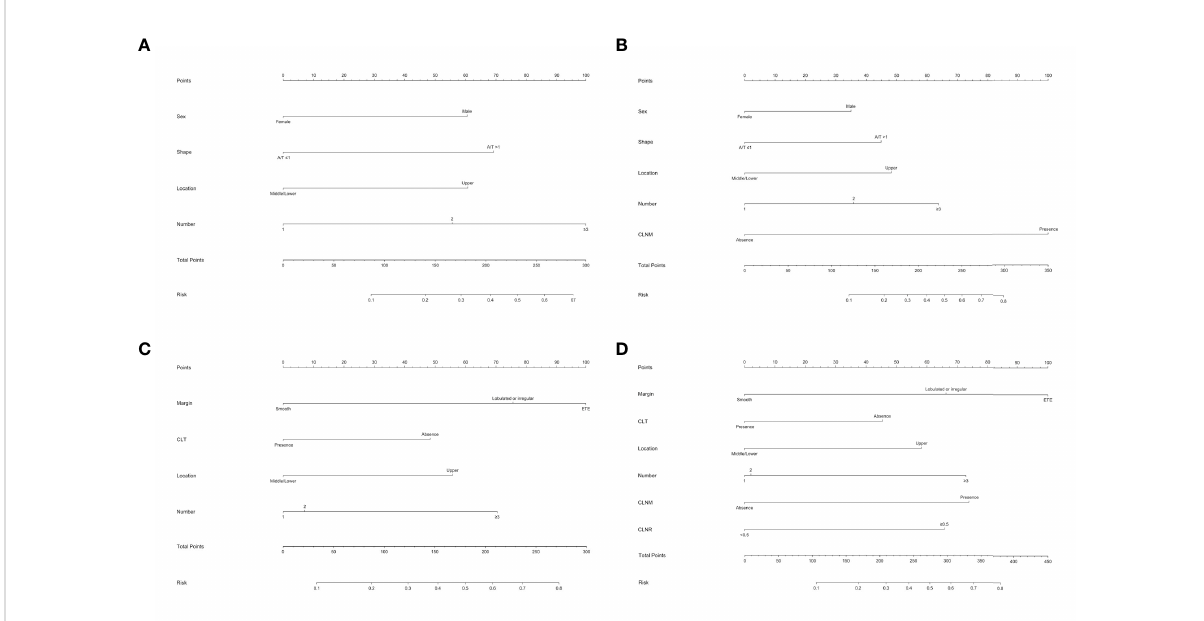
FIGURE 3 Nomogram for predicting LNM in patients with PTC. (A) Preoperative nomogram for predicting LLNM in PTMC patients; (B) postoperative nomogram for predicting LLNM in PTMC patients; (C) preoperative nomogram for predicting LLNM in macro-PTC patients; (D) postoperative nomogram for predicting LLNM in macro-PTC patients.